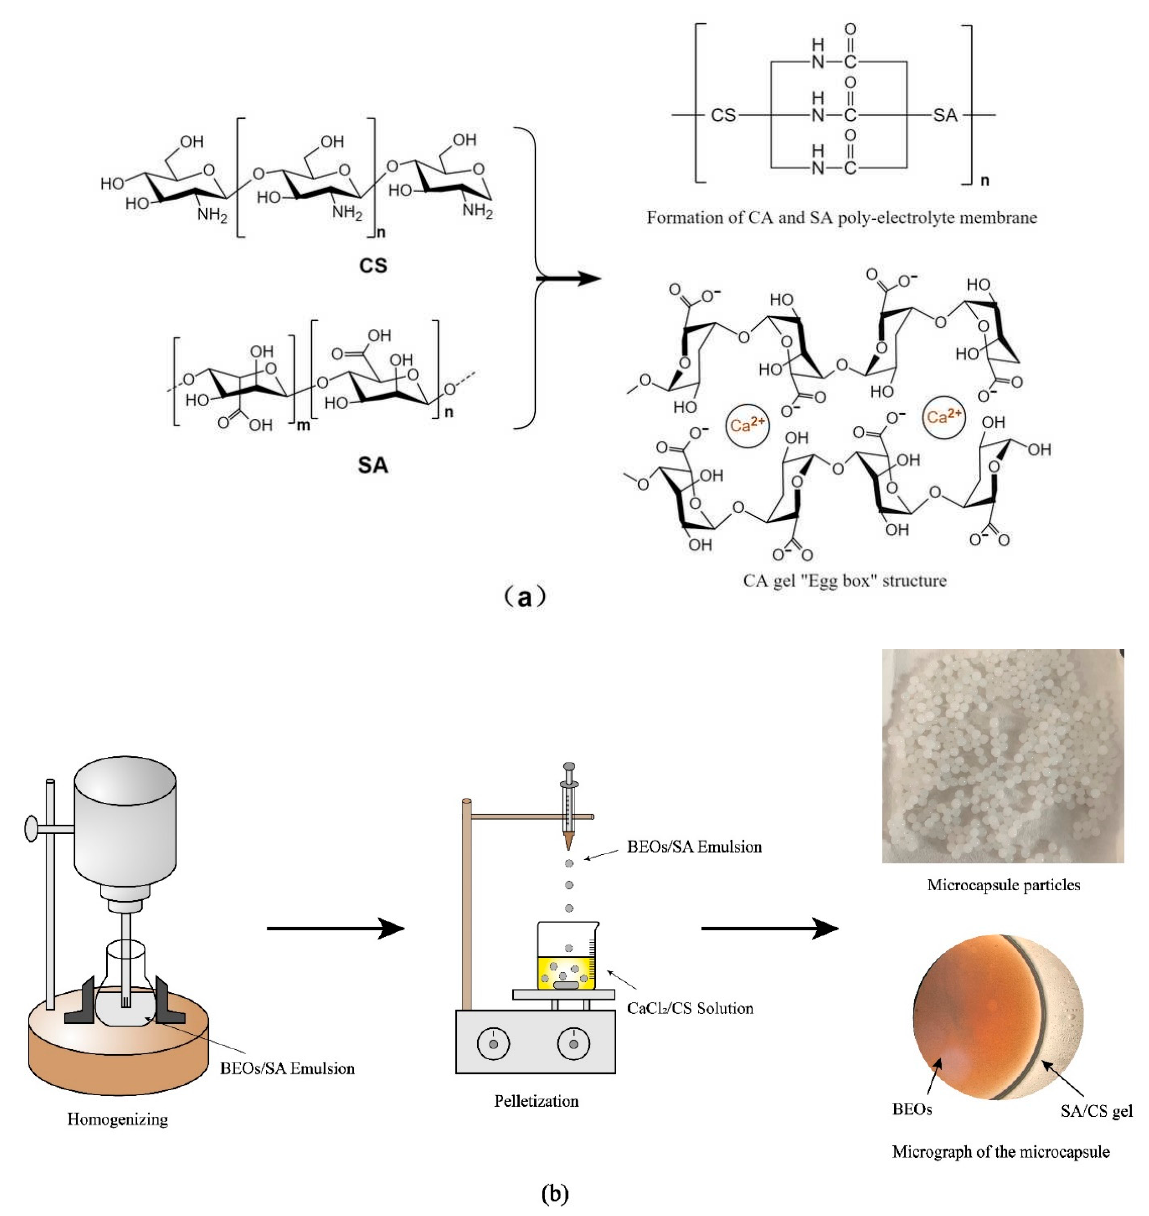
Figure 7. Preparation process and schematic diagram of the BEO microcapsules. ( a ) was the schematic diagram of the BEO microcapsules and ( b ) was the preparation process of the BEO microcapsules.